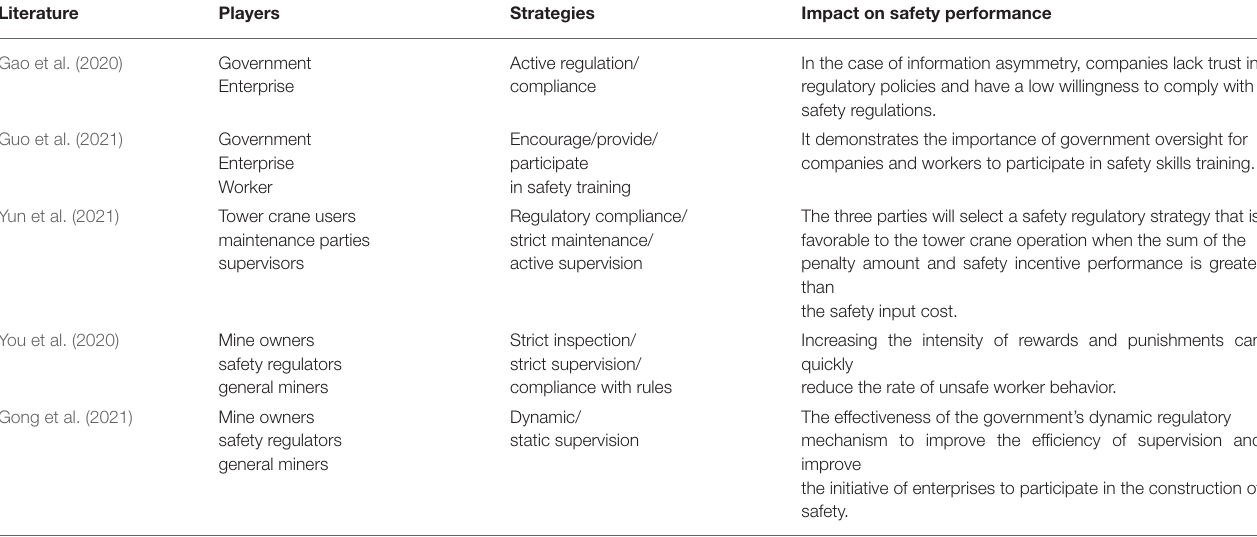
TABLE 1 | Review the game and influence of participants on safety